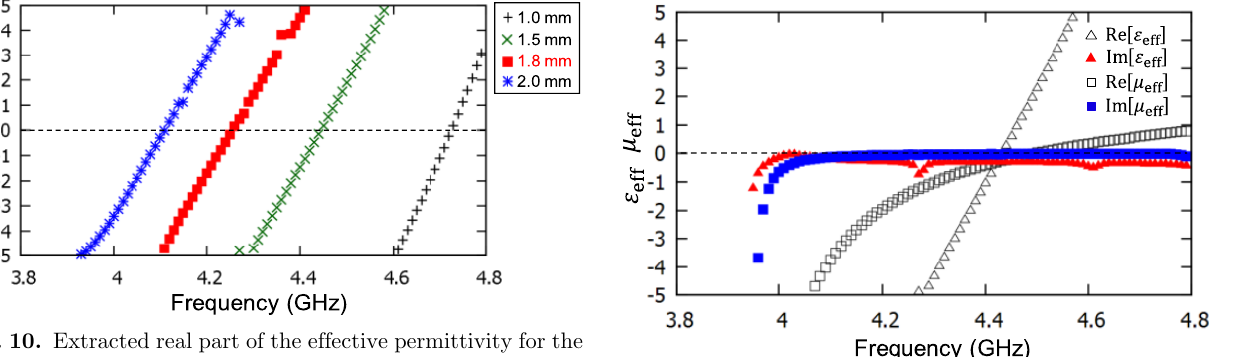
Fig. 12. Real and imaginary parts of effective permittivity and permeability for the designed metamaterial with d = 1.5mm.